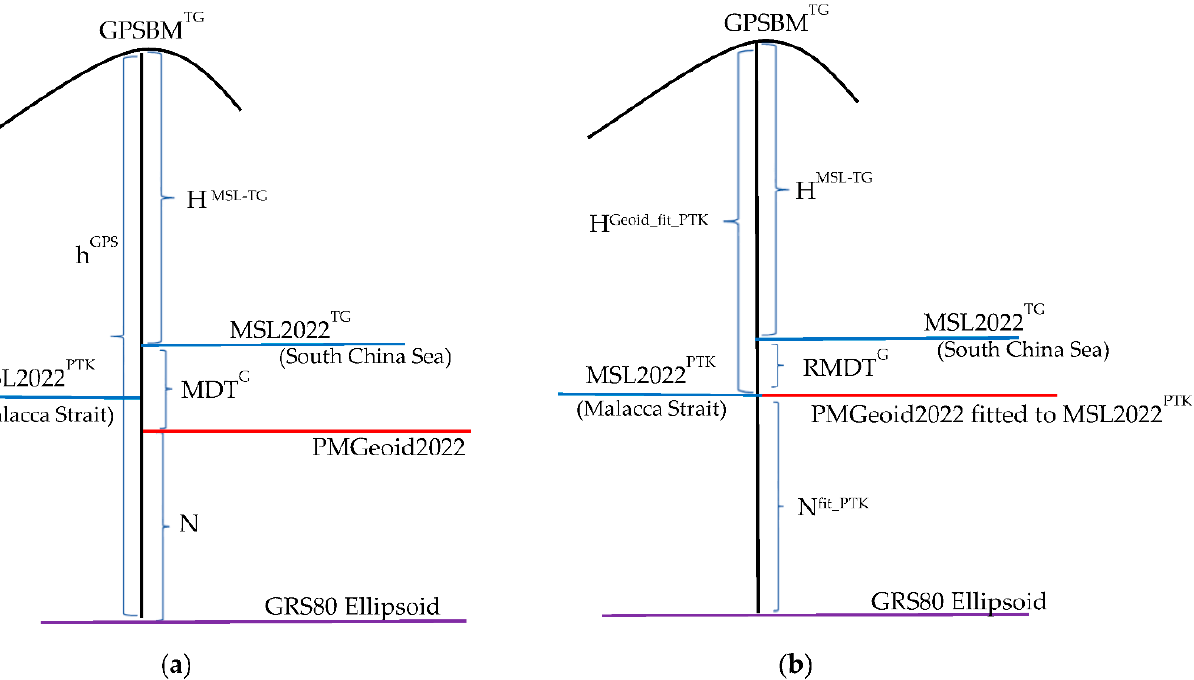
Figure 14. ( a ) Absolute MDT G at TG-GPSBM: MDT G = h GPS − N − H MSL-TG ; ( b ) Relative-MDT G between PTK (Malacca Strait) and GPSBM TG (South China Sea): RMDT PTK-TG = H Geoid_fit_PTK − H MSL-TG . On the other hand, the unfitted geoid model PMGeoid2022 allows the marine MDT to be determined from the altimetry dataset as MDT SALT = MSS − N . MSS denotes the DTU21 mean sea surface height, which has been transformed from the TOPEX reference ellipsoid (used in the altimetry grids) to WGS84. Figure 15 shows a relatively smooth DTU21-derived MDT SALT signal, with an abrupt increase southward in the Malacca Strait. Other narrow straits connecting major world seas exhibit the same phenomenon. The features seen in the narrow channels around Singapore are most likely due to MSS errors, but they can also be due to geoid errors, as no gravity data is available for the Indonesian islands situated in the Malacca Strait. The MDT SALT on the east coast of Peninsular Malaysia appears to be higher than on the west coast. It shows that the value of MDT on the east coast is between 1.0 m and 1.1 m. Meanwhile, the MDT value on the west coast is between 0.75 m and 1.0 m. Figure 15 illustrates the RMDT G or sea slopes relative to TG PTK at each of the ten (10) TG-GPSBM locations. The negative values (RMDT < 0) indicate that the MSL2022 TG are lower than MSL2022 PTK , which is the case for the northern half of Malacca Strait. Meanwhile, positive values (RMDT > 0) indicate that the MSL TG are higher than MSL PTK in the southern half of Malacca Strait and the South China